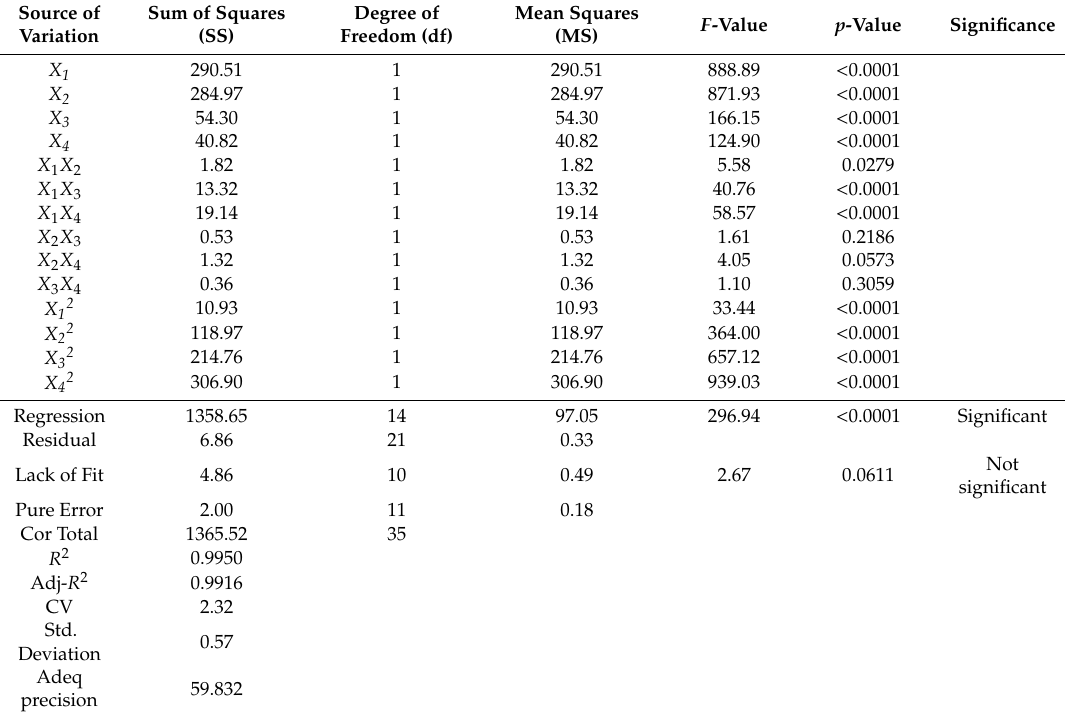
Table A4. Estimated coe ffi cients via a response surface quadratic model and ANOVA for the response surface methodology (RSM)